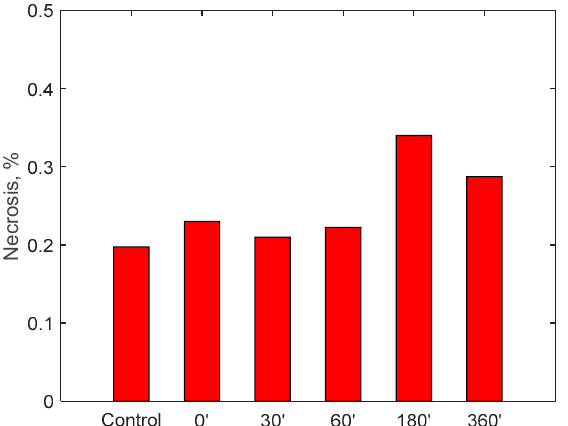
Figure 14. Necrosis on monocytes cell line U937 after incubation with fluid circulated in the RAP for up to 360 minutes.